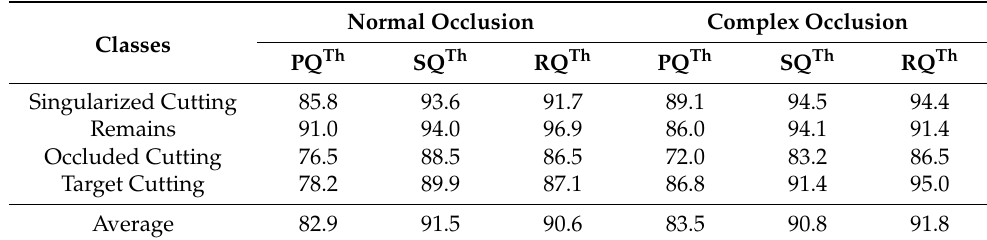
Table 2. Panoptic segmentation results with AdaptIS on the presented occluded plants